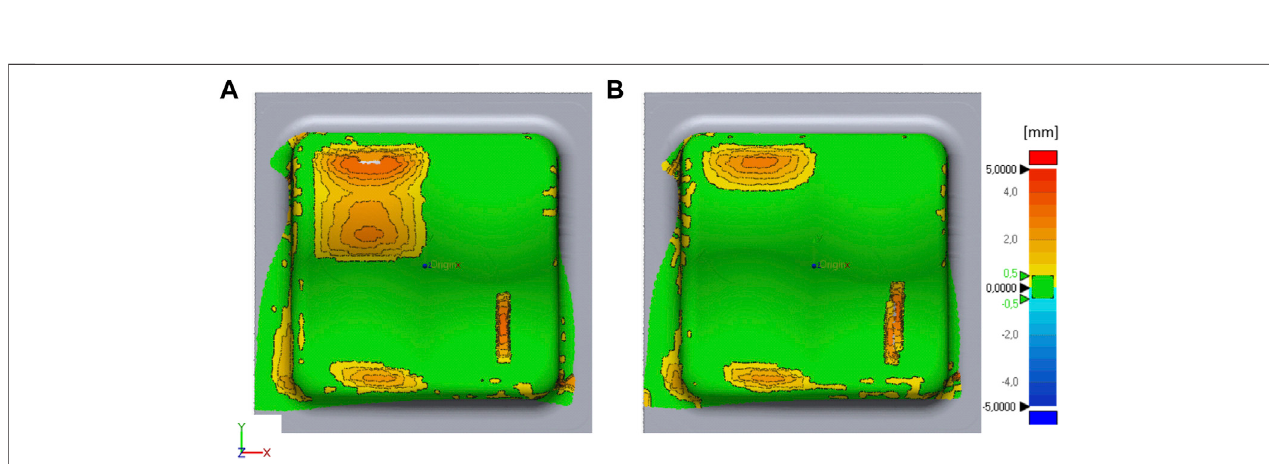
FIGURE 13 | Effects of (A) omitted rate dependency, (B) omitted mass scaling, (C) lower clamping pressure at the fi xation points plotted against the benchmark simulation.The distance betweenthe benchmark simulation(reference) and modi fi ed simulation iscolorcoded, where green areas are ±0.5 mm, yellowtored areas are > + 0.5 mm, and blue areas < − 0.5 mm apart.